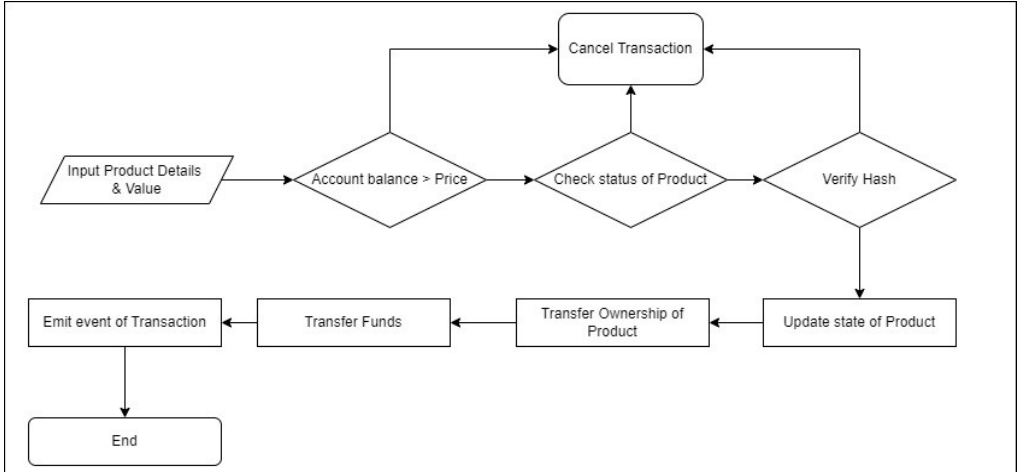
Fig. 7 . Verification of Product and